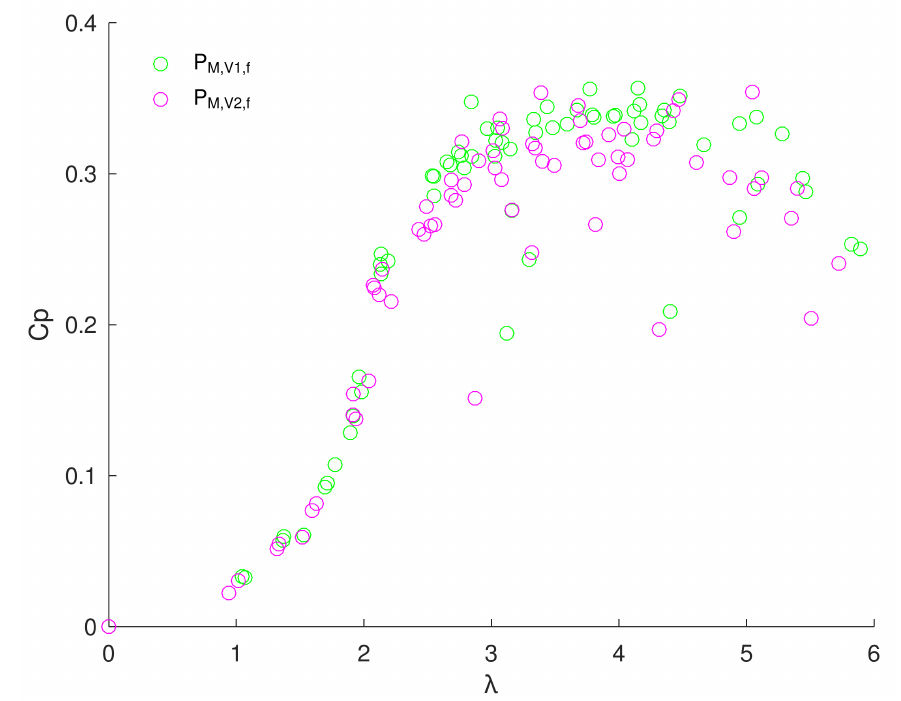
Figure 8. C p – λ data based on of filtered Vector 1 vs Vector 2 data.